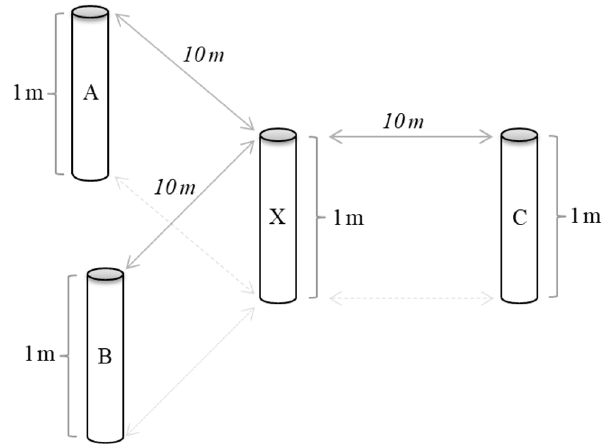
Figure 2. The sampling setup for locations with multiple snow pro- files. The profiles A, B and C have a sampling distance of roughly 10m to the central profile. Due to time constraints, locations 19 (three profiles), 11 and 13 (two profiles) have been sampled differ- ently.